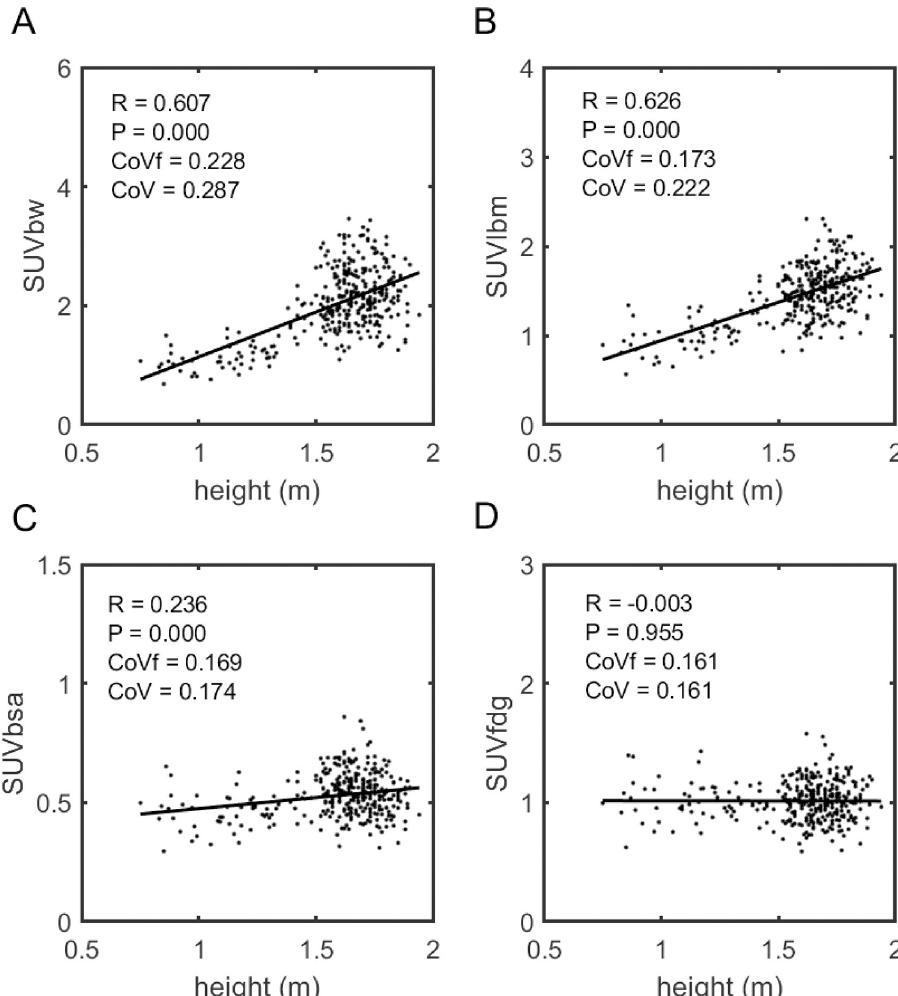
Fig 3. Training data, SUVs as a function of height. Scatter plots of liver measurements like those shown in Fig 2 except here plotted as a function of patient height. Again, only SUV fdg has no significant correlation.